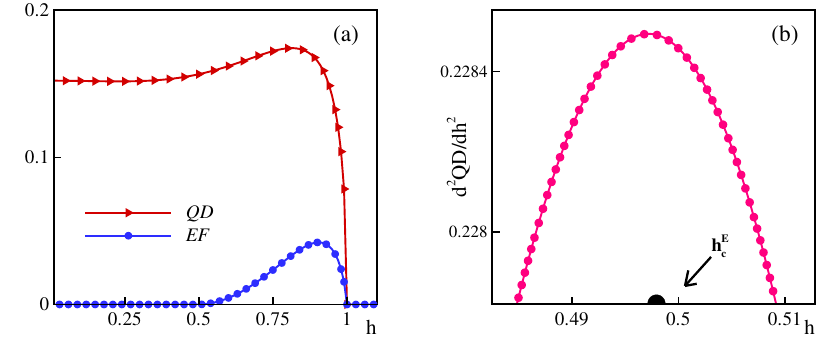
Figure 2. ( a ) Ground state of QD and EF; and ( b ) second derivative of the QD in the vicinity of h E c , versus magnetic field for the 2N pair of spins.